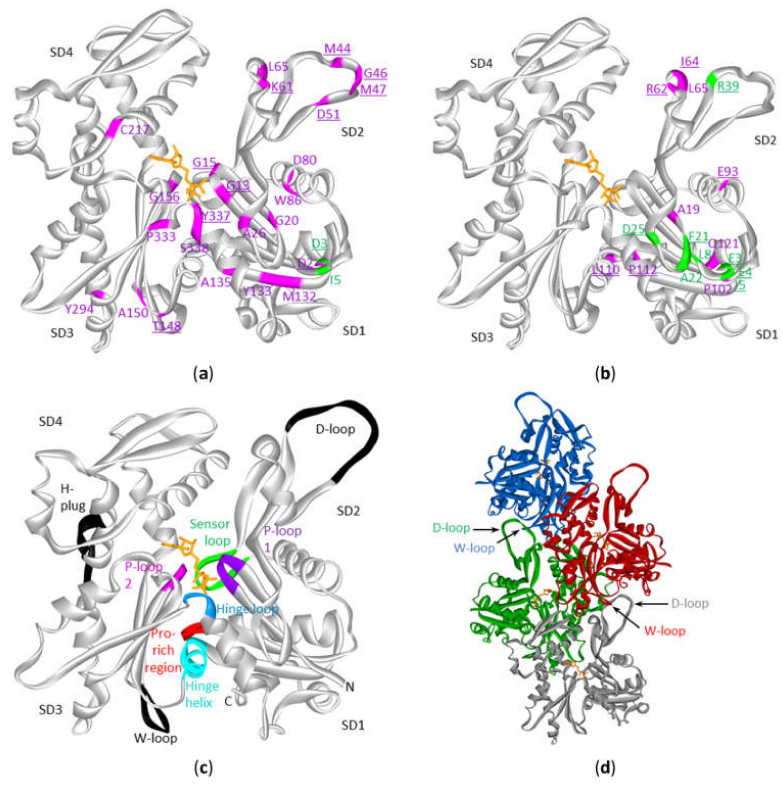
Figure 4. Mutations in cytoplasmic actins in DLBCL and multiple myeloma plotted on the monomeric or polymeric form of actin. Sites of mutations in ACTB ( a ) or ACTG1 ( b ) in either di ff use large B-cell lymphoma (magenta) and multiple myeloma (green) (see Table S3) with indication of subdomains (SD) 1 to 4 (amino acid residues of SD1: 1–32, 70–144, 338–375; SD2: 33–69; SD3: 145–180, 270–337; SD4: 181–269). The data are plotted on the structure of the monomeric form of ACTB